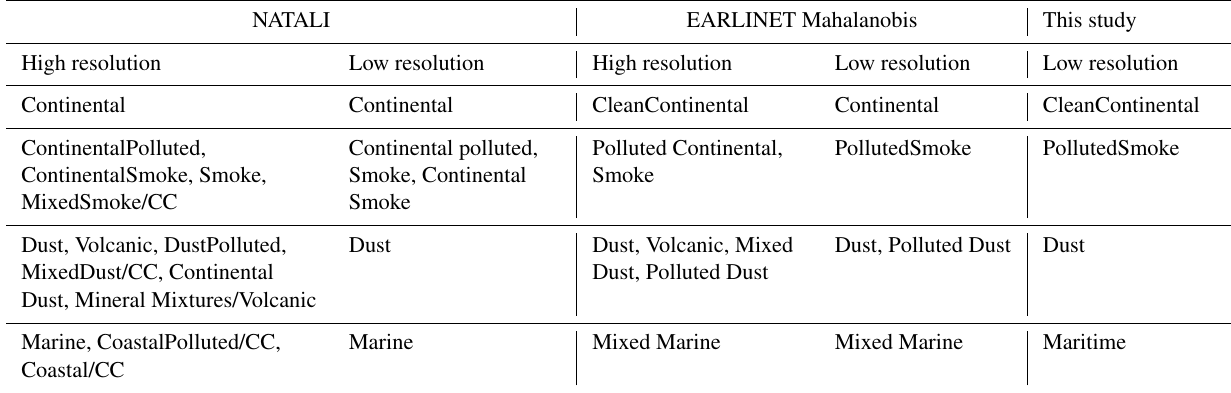
Table 1. Nomenclature of the aerosol types used in the high- and low-resolution (without depolarization) modes for both automatic typing techniques and the correspondence with the ones used in this study.